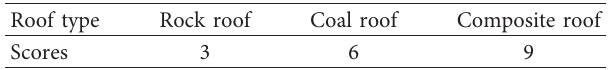
Table 3: The scores of roof characteristics.